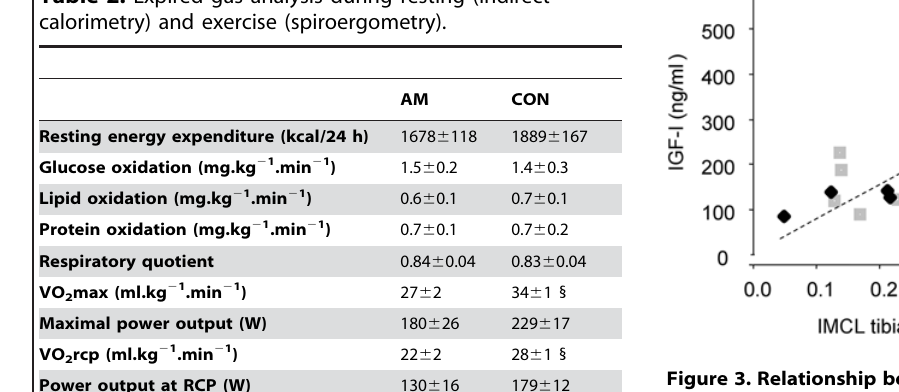
Figure 3. Relationship between ectopic lipid content of tibialis muscle (IMCLt) and plasma concentrations of insulin-like growth factor-1 (IGF-I) in 7 subjects with previous acromegaly (AM, black squares) and 7 age- and body mass index-matched controls (CON, grey squares) (r=0.726, p , 0.05).